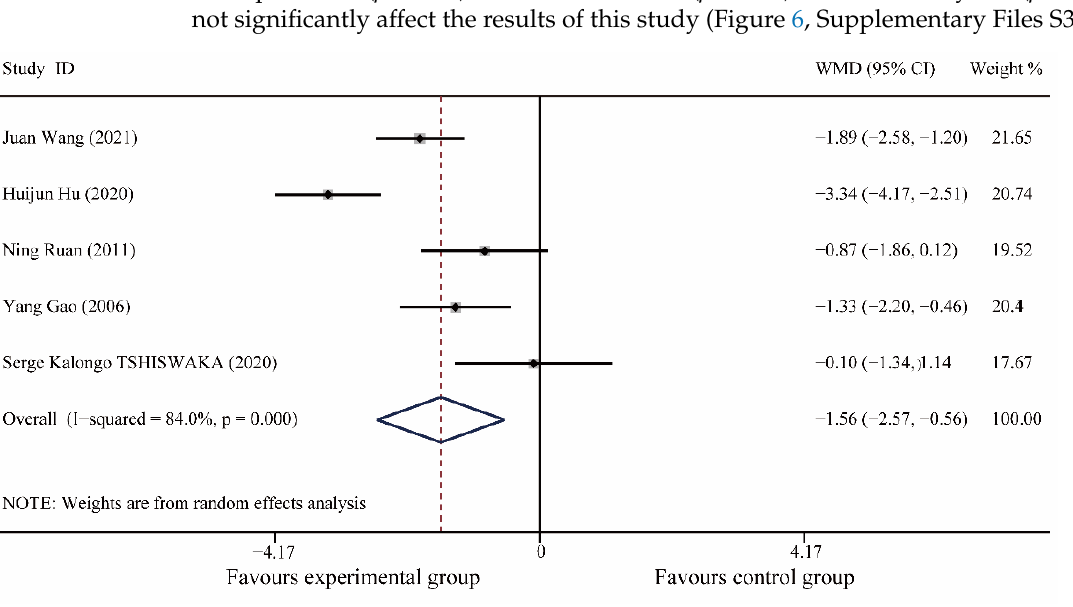
Figure 6. Forest plot of postoperative pain scores [18,19,22,23,33].